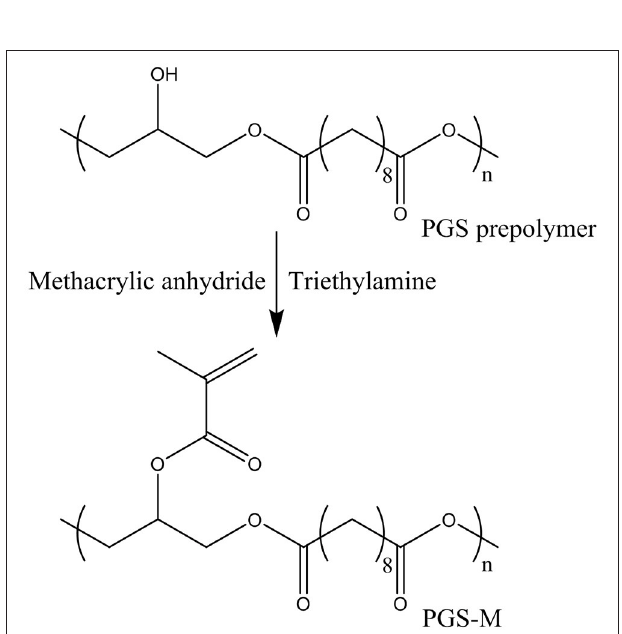
FIGURE 2 | Synthesis of PGS-M